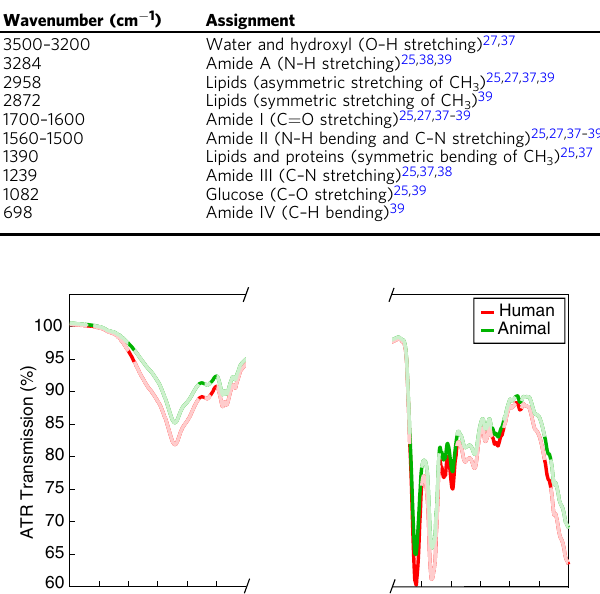
human – animal PLSDA model with fi ve LVs, 49 out of 50 human blood spectra were correctly classi fi ed in the external validation.